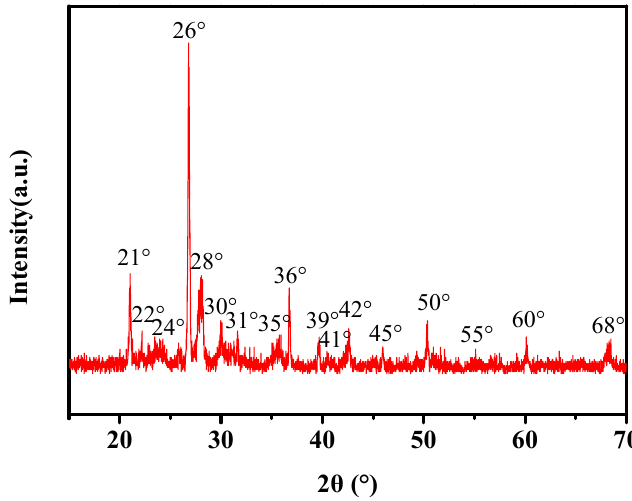
Figure 7. X-ray diffraction spectra of inorganic fillers in sample mortar. Figure 7. X-ray di ff raction spectra of inorganic fillers in sample mortar. Coatings 2020 , 10 , x FOR PEER REVIEW